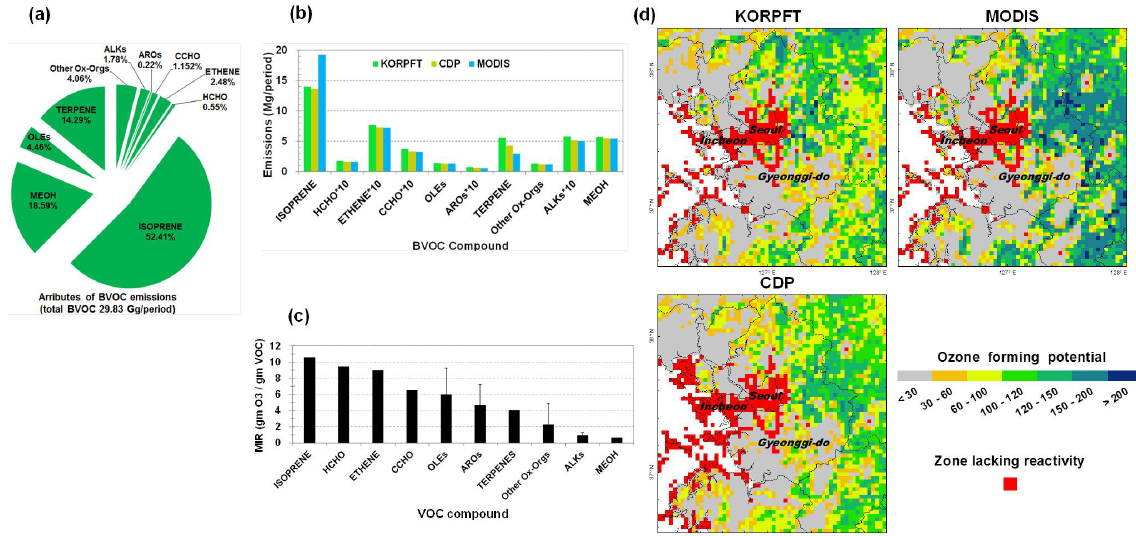
Figure 7. Composition and distribution of the estimated BVOC emissions, along with spatial distribution of the estimated net ozone-forming potentials of biogenic VOC emissions. The total BVOC in (a) was derived by averaging the total BVOC emissions of the three sources of data. The 10 BVOC compound groups in (b) are arranged in descending order following their O 3 reactivity, i.e., MIR shown in (c) . The distributed net ozone-forming potentials in (d) were calculated by aggregating the O 3 -forming potentials (OFPs) for 10 BVOC compound groups calculated by multiplying the emissions by their corresponding MIR values at each grid cells. The red zones denote the zones missing BVOC reactivity due to the lacking biogenic emissions during the OFP